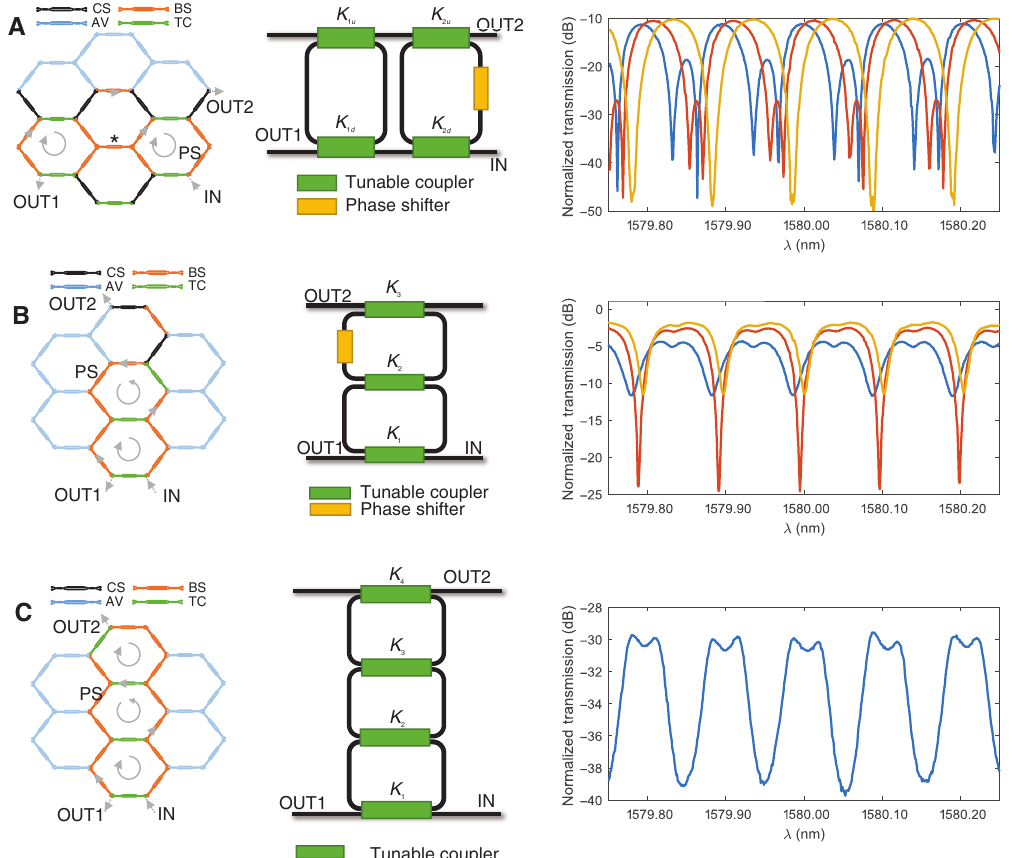
Figure 12: Experimental results for tuneable multicavity ring filters programmed over the silicon hexagonal waveguide mesh of Figure 9A. Waveguide mesh connection diagram (left), circuit layout (middle) and measured modulus (right) for different values of the coupling constants K and K in the case of (A), a 6-BUL side-coupled integrated spaced sequences of optical resonator (SCISSOR) filter; (B) a 6-BUL 1 2 coupled resonator waveguide (CROW) filter; (C) a 6-BUL CROW. For each case, the first column shows the 7-cell hexagonal waveguide mesh configuration, where each Mach-Zehnder interferometer (MZI) device is represented by a given colour following the code given in Figure 5. The second column shows the layout of the implemented structure, while the third column shows the measured modulus for the synthe- sized configuration where the input is in the IN port and the outputs are the OUT1 and OUT2 ports. BUL, basic unit length; PS, phase shifter; CS, cross state; BS, bar state; AV, available; TC, tuneable